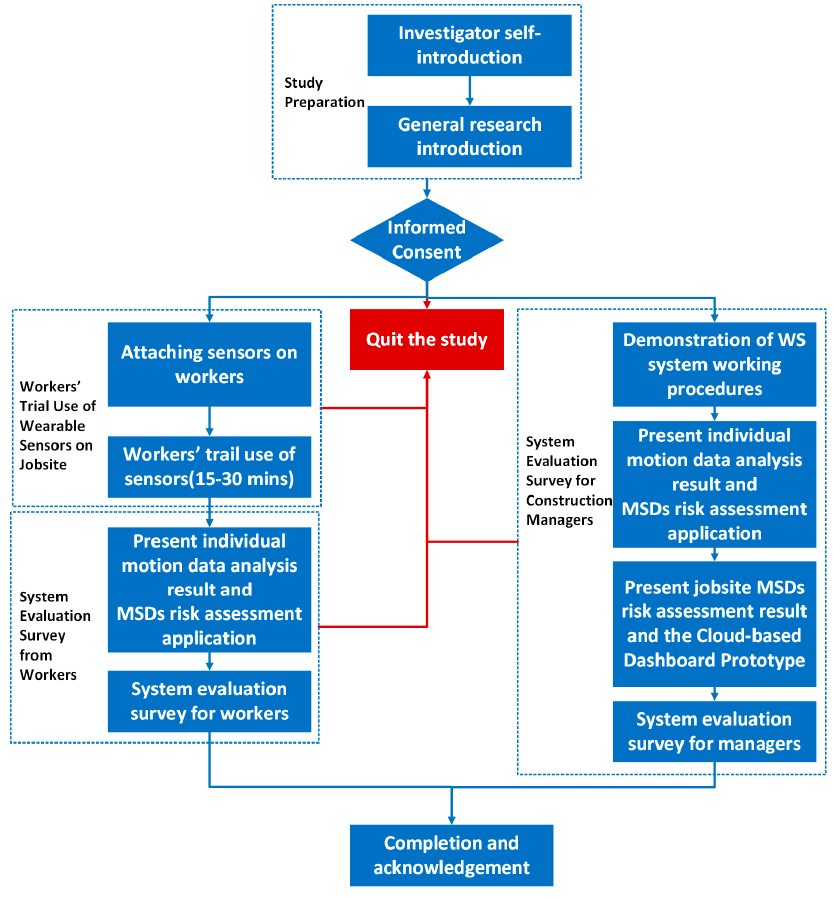
Figure 8. Implementation procedure for evaluation